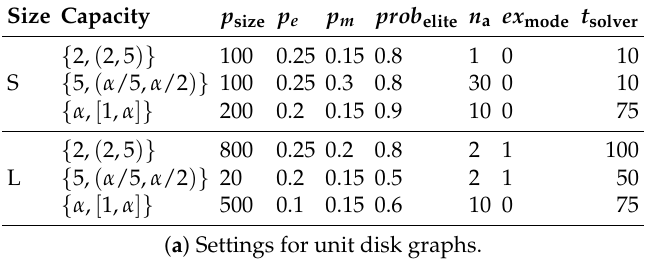
( b ) Settings for general graphs. Table 2. B ARRAKUDA parameter values generated by irace for the instances from the literature.